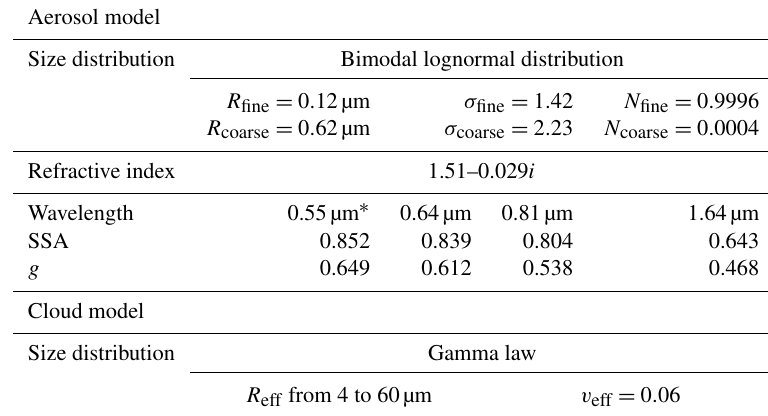
Table 1. Aerosol and cloud properties used to compute the radiances LUT of the SEVIRI retrieval.